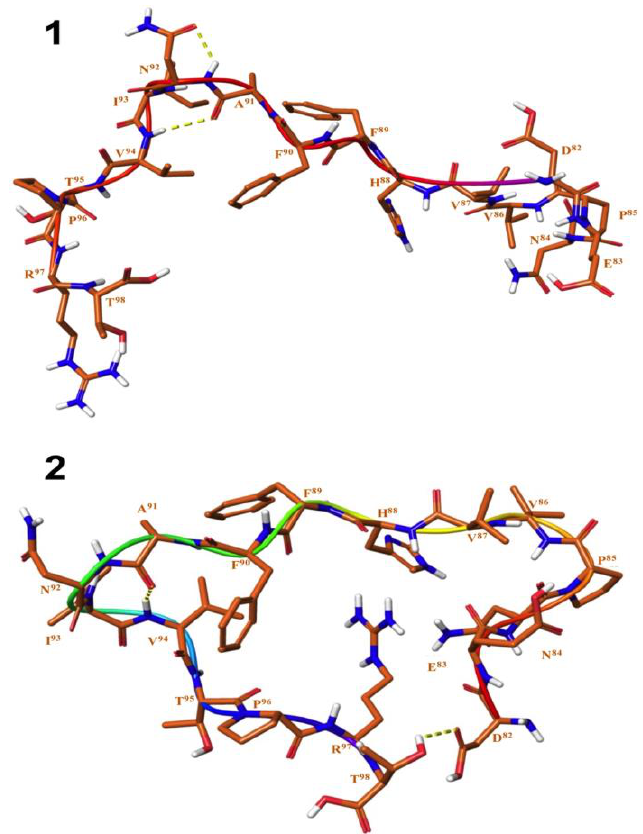
Figure 3. Low energy conformers of the linear MBP 82–98 (A 91 ), which satisfies the NOE distance constraints. Both demonstrate the interaction between A 91 and V 94 , while the interaction between the terminal D 82 and T 98 is apparent for conformer 2.